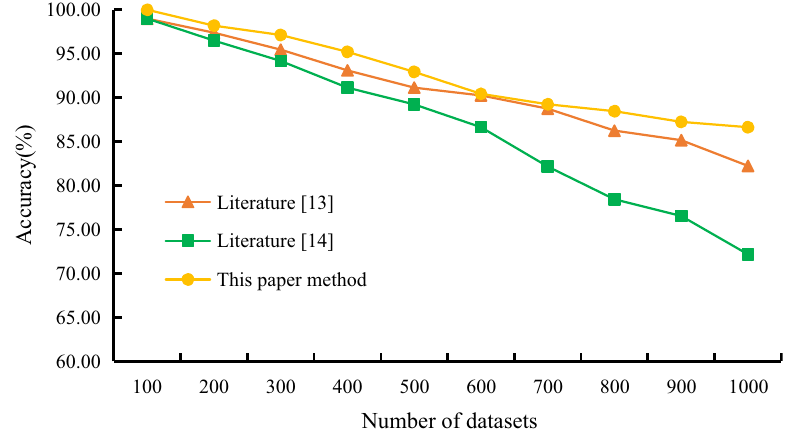
Figure 6: Comparison and analysis of accuracy of three methods.